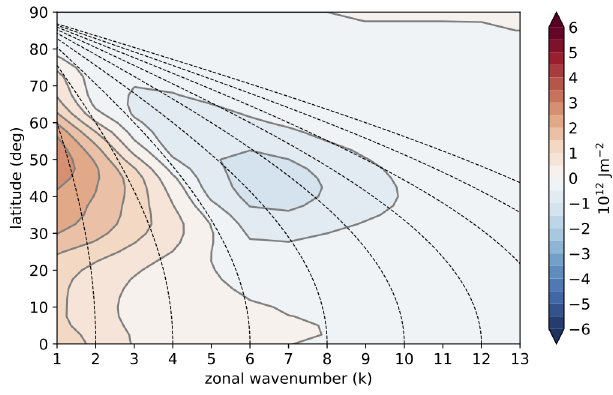
Figure 5. Vertically integrated eddy kinetic energy as a function of zonal wavenumber and latitude. Data are from the ERA-Interim reanalysis using all calendar months, and the time mean stationary waves have been removed. Dashed lines connect points with the same zonal length scale.